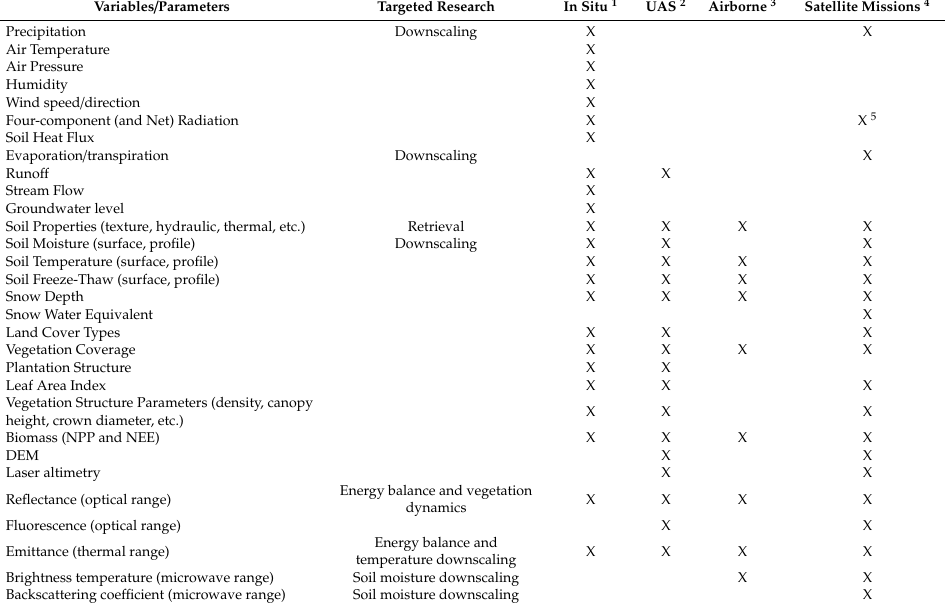
Table 1. Essential variables / parameters measured in iAqueduct